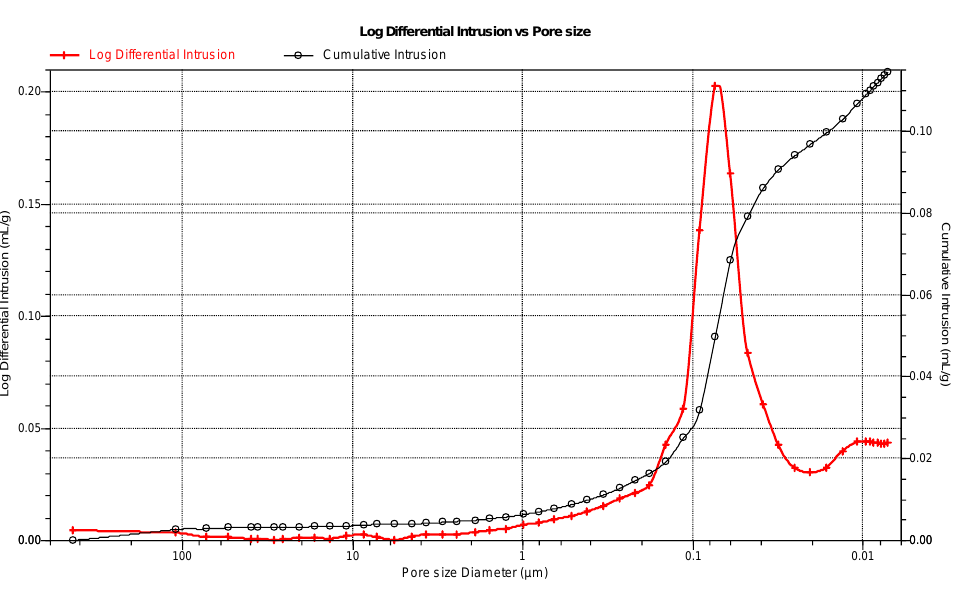
Figure 5. Pore size distribution in C.I.3 specimen.